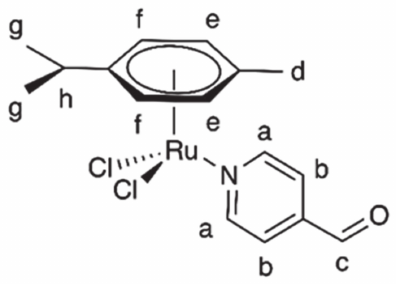
Figure 9. [( η 6 -p-cym)Ru(4-formylpyridine)Cl 2 ] (IC1). 3.1.5. [( η 6-p-cym)Ru(N,N (cid:48) -bpy)(4-formylpyridine)](CF 3 SO 3 ) 2 (IC2) IC1 (0.10 g, 0.22 mmol) was dissolved in 15 mL of dry CH 2 Cl 2 in a Schlenk flask with a nitrogen atmosphere. At the same time, an AgCF 3 SO 3 (0.11 g, 0.43 mmol) solution was